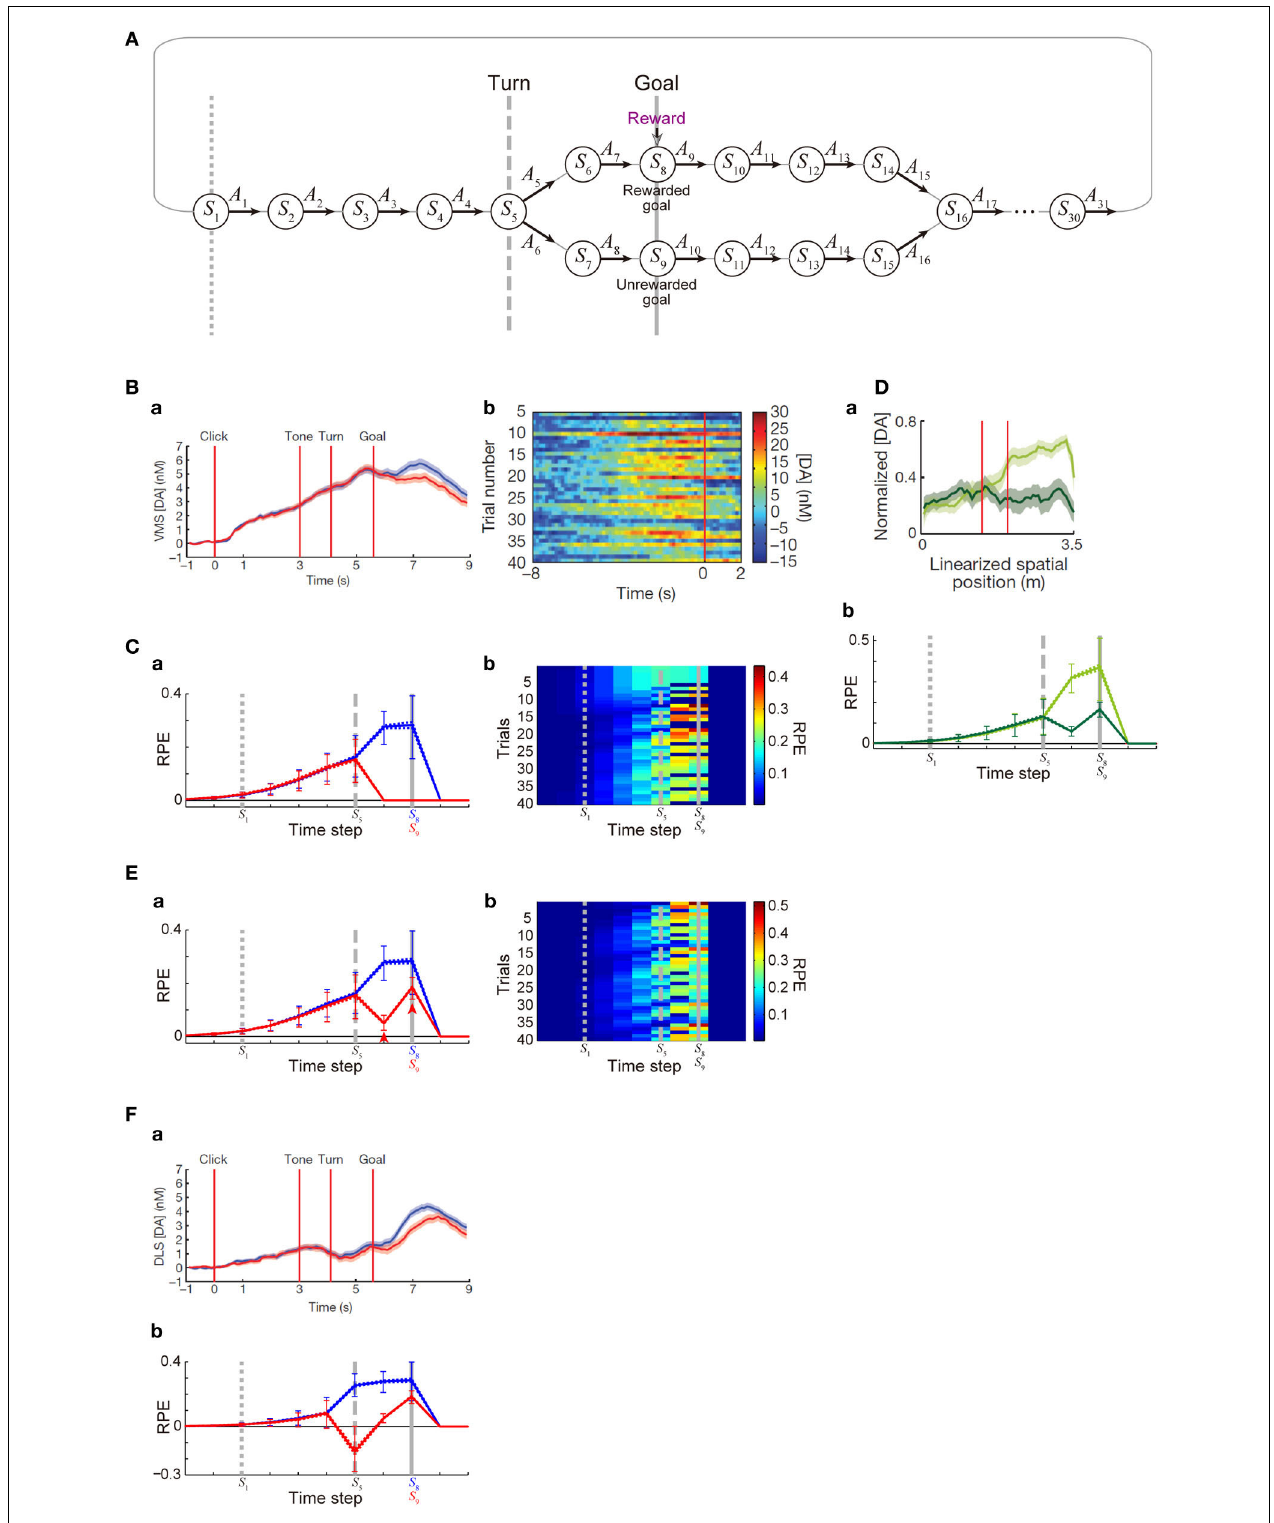
FIGURE 4 | DA/RPE ramping in maze task with rewarded and unrewarded goals. (Ba,Bb,Da,Fa) were reprinted by permission from Macmillan Publishers Ltd: Nature (Howe et al., 2013), copyright (2013). (A) Simulated free-choice T-maze task with rewarded and unrewarded